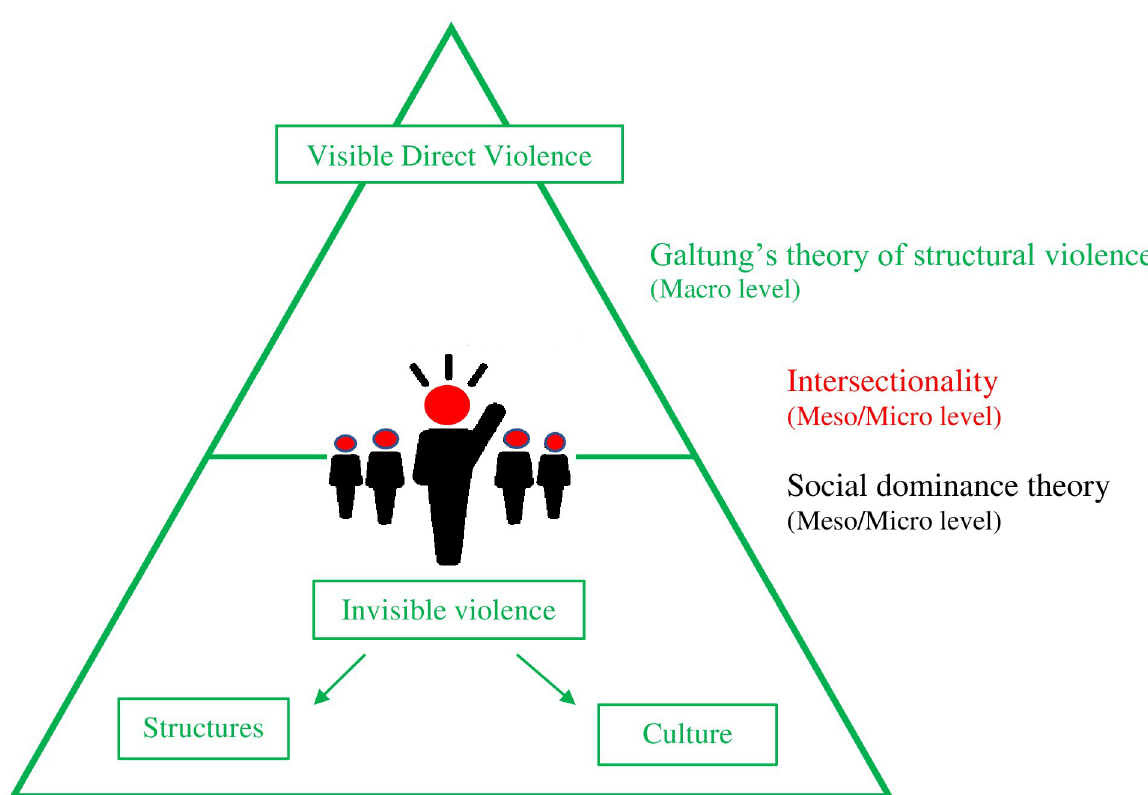
Fig 1. Integrated theoretical